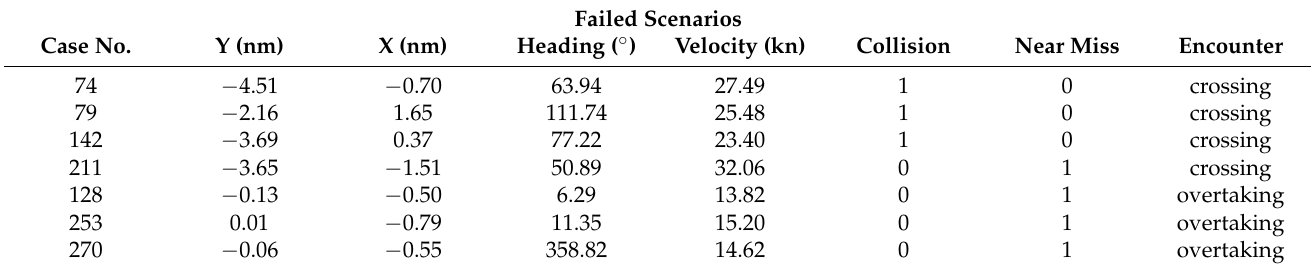
Table 10. Initial settings of failed scenarios.